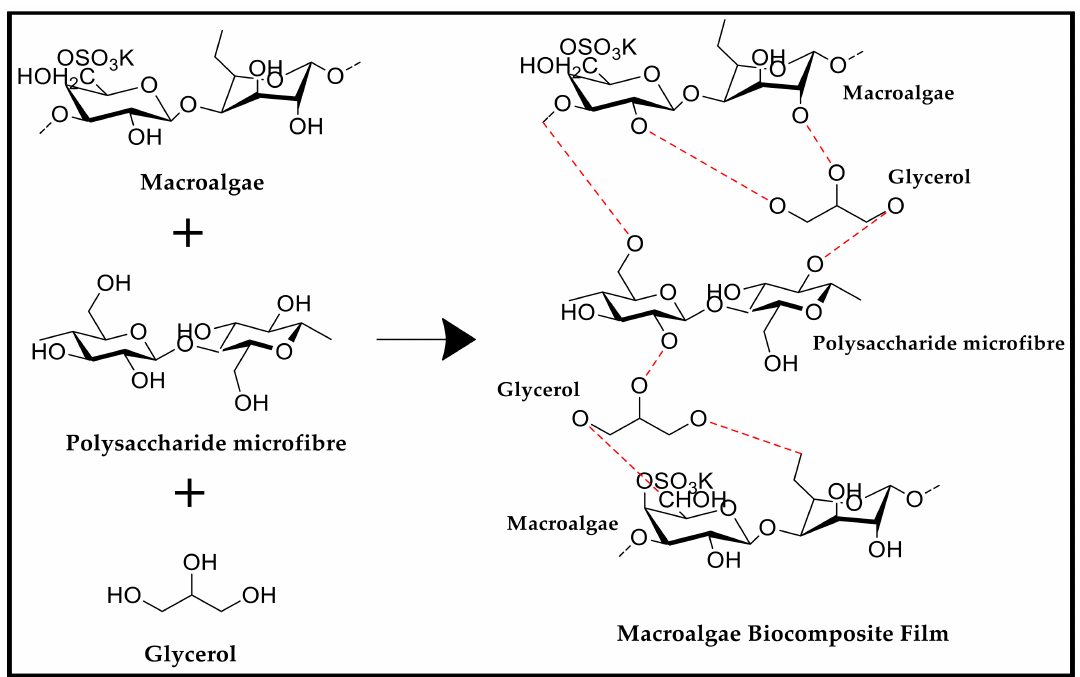
Figure 4. Schematic representation of intermolecular interaction between macroalgae (SW) and polysaccharide microfibre (GL-MCC) in the presence of